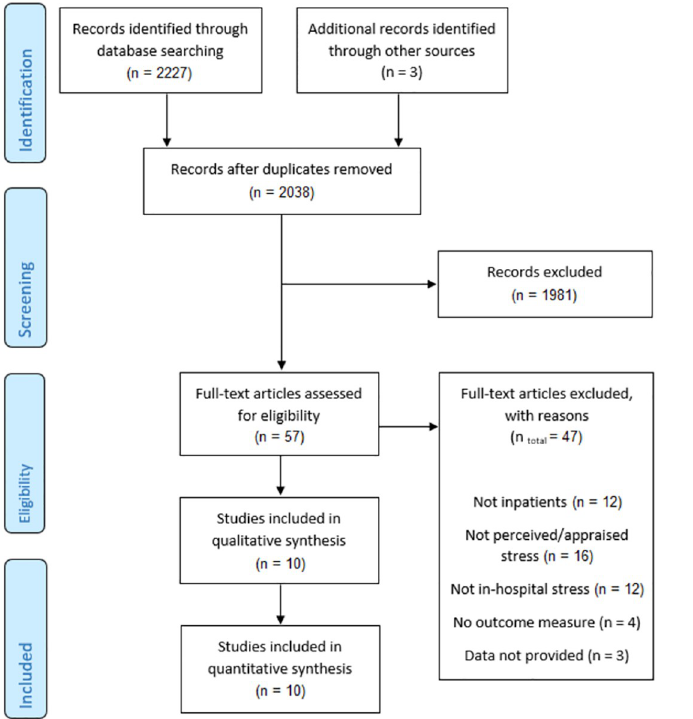
Fig 1. PRISMA flow diagram presenting an overview of the selection